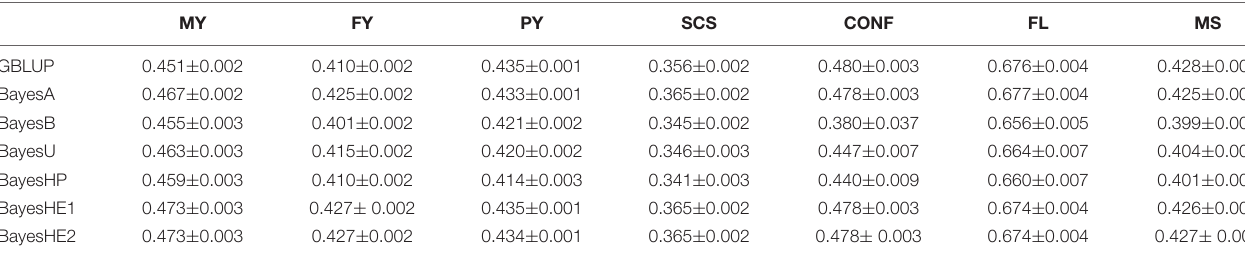
TABLE 2 | Prediction accuracies of seven traits of dairy cattle using six-fold cross-validation with five replications. MY